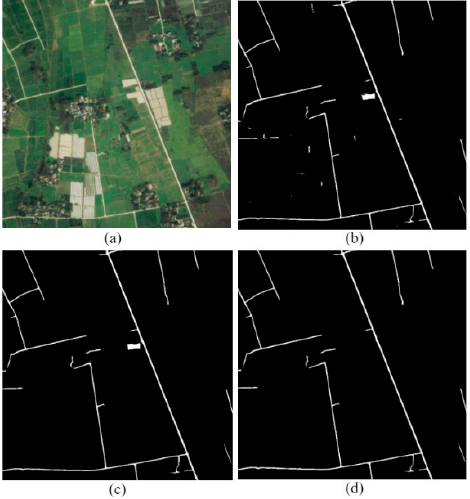
Figure 12. Results in the general scenes: ( a ) original image; ( b ) label; ( c ) D-LinkNet; ( d ) DenseNet (k = 24) + stem block;